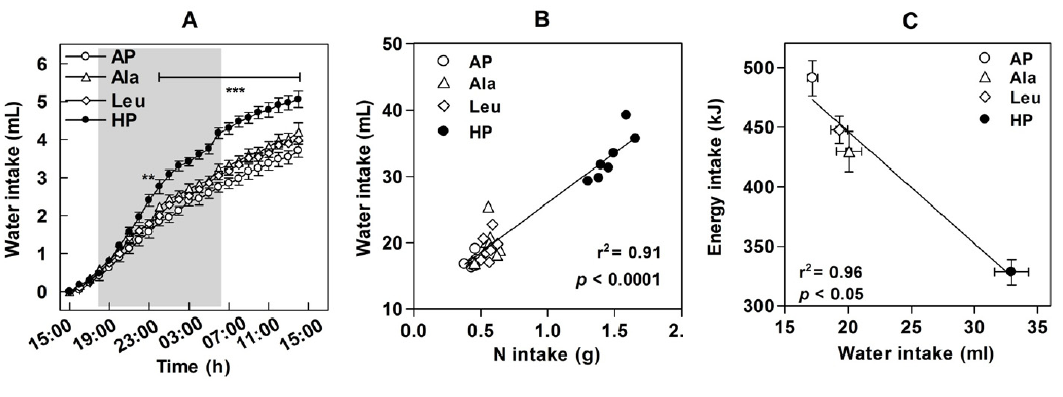
Figure 4. Water intake. Ten weeks old male C57BL/6 mice were fed for seven days ad libitum with experimental semisynthetic high-fat diets (20% w / w of fat) containing different protein and leucine and alanine concentrations. AP, adequate protein (10% w / w of whey protein); HP, high-protein (50% w / w of whey protein); Leu, AP supplemented with L -leucine corresponding to HP (+6% w / w L -leucine, 0.572 mole); Ala, AP supplemented with equimolar L -alanine (+4.5% w / w L -alanine, 0.572 mole). ( A ) Water intake on the first day of dietary intervention; ( B ) Correlations of water intake with nitrogen intake; ( C ) Correlations of water intake with energy intake. Values in ( B ) and ( C ) are means ± SEM ( ** p < 0.01, *** p < 0.0001)